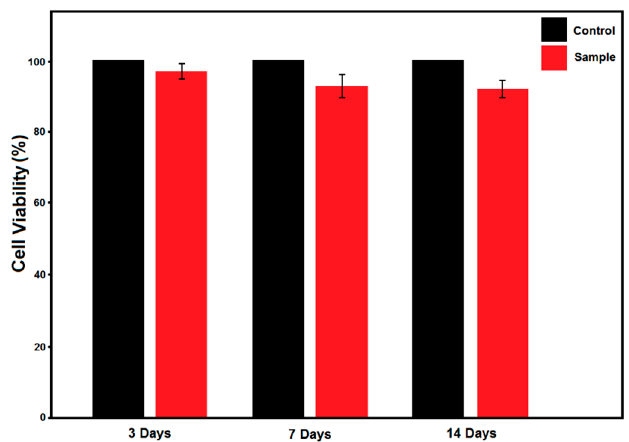
Figure 7. Cell viability of the sample prepared via IL-assisted hydrothermal method, for different periods of time, at 37°C, as measured by MTT assay.